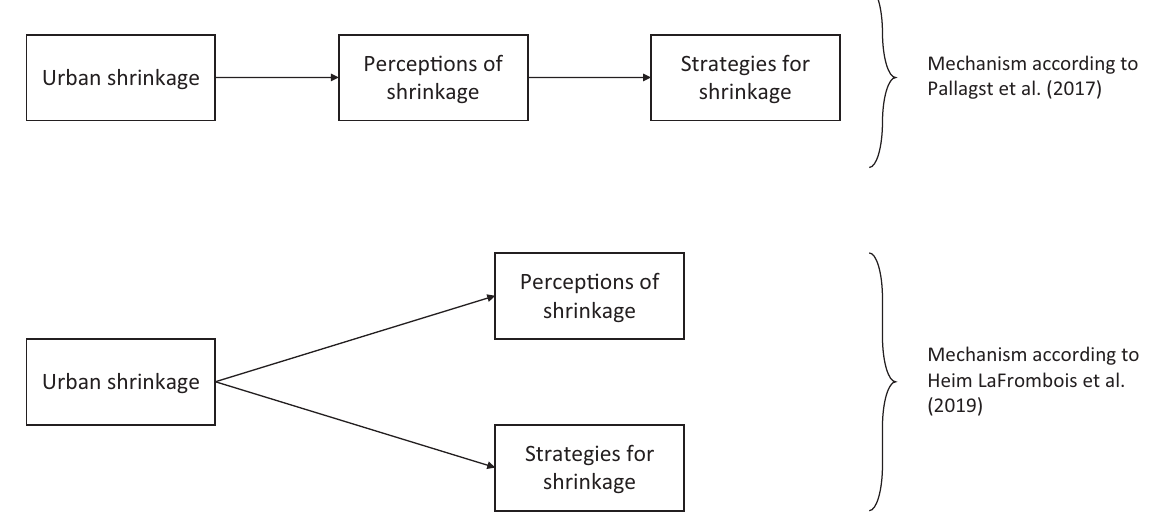
Figure 1. Schematic showing different proposed mechanisms for which the situation of urban shrinkage affects a city’s strategies for responding to